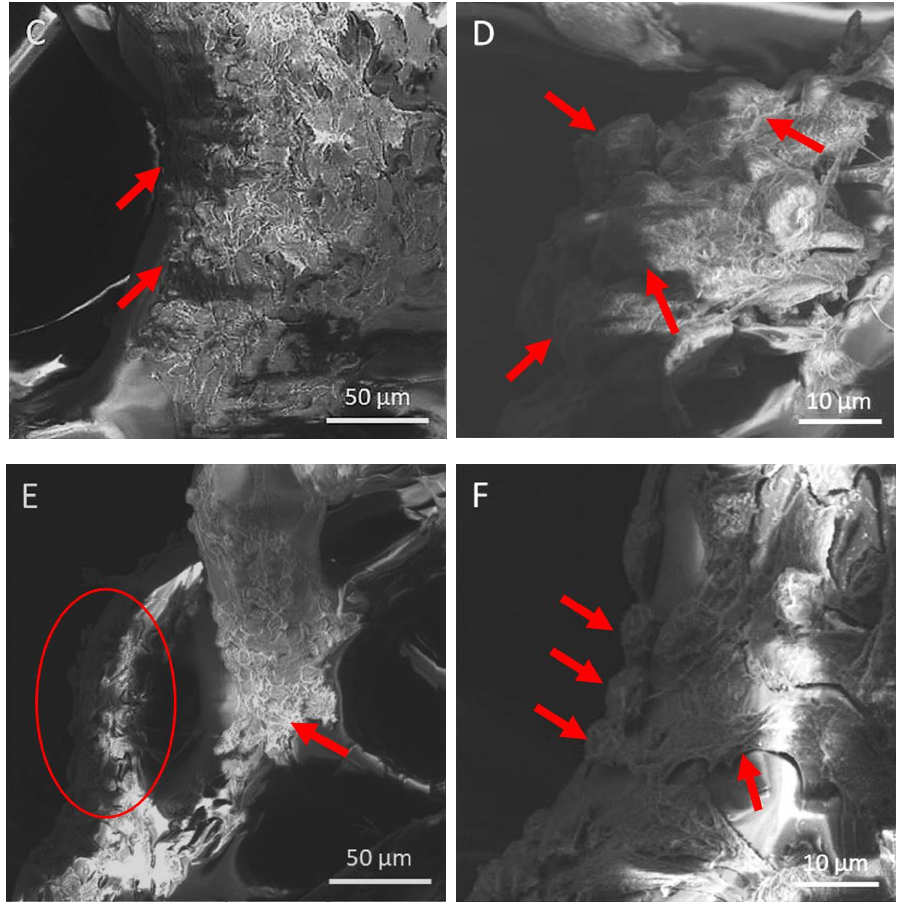
Figure 7. SEM images of cultured LSCs: ( A , B ) PLA, ( C , D ) PLA/silk fibroin, and ( E , F ) PLA/gelatin scaffolds. The cells seemed to be firmly attached to the surfaces of microfibers, and the LSCs showed the formation of colonies in flattened larger conformations. The side views of the microfibers also revealed 3D spherical LSCs agglomerations (Figure 8A), but the cells were also forming bead-on-string conformations around the filament surfaces (Figure 8B). Similarly, sphere-shaped single or numerous LSCs were observed on electrospun PCL or PCL-gelatin scaffolds [14].